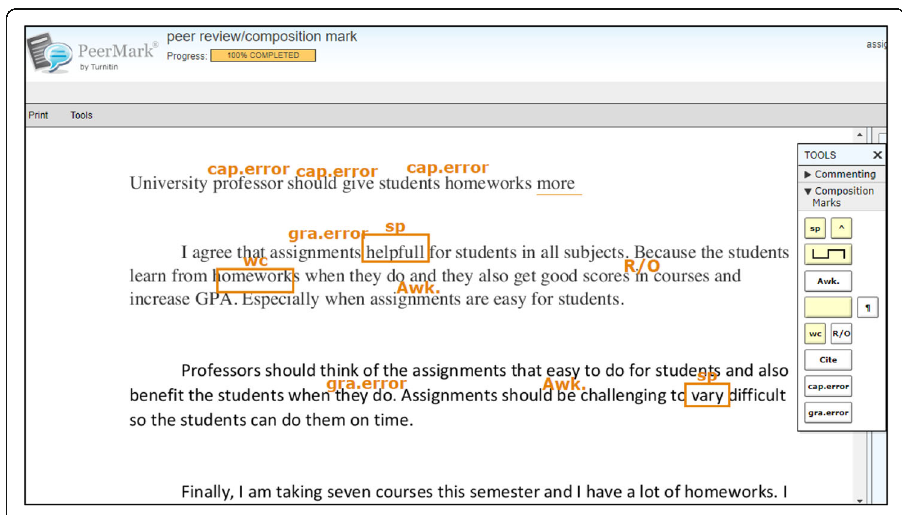
Fig. 3 Composition marks that peer reviewers can drag and drop while providing